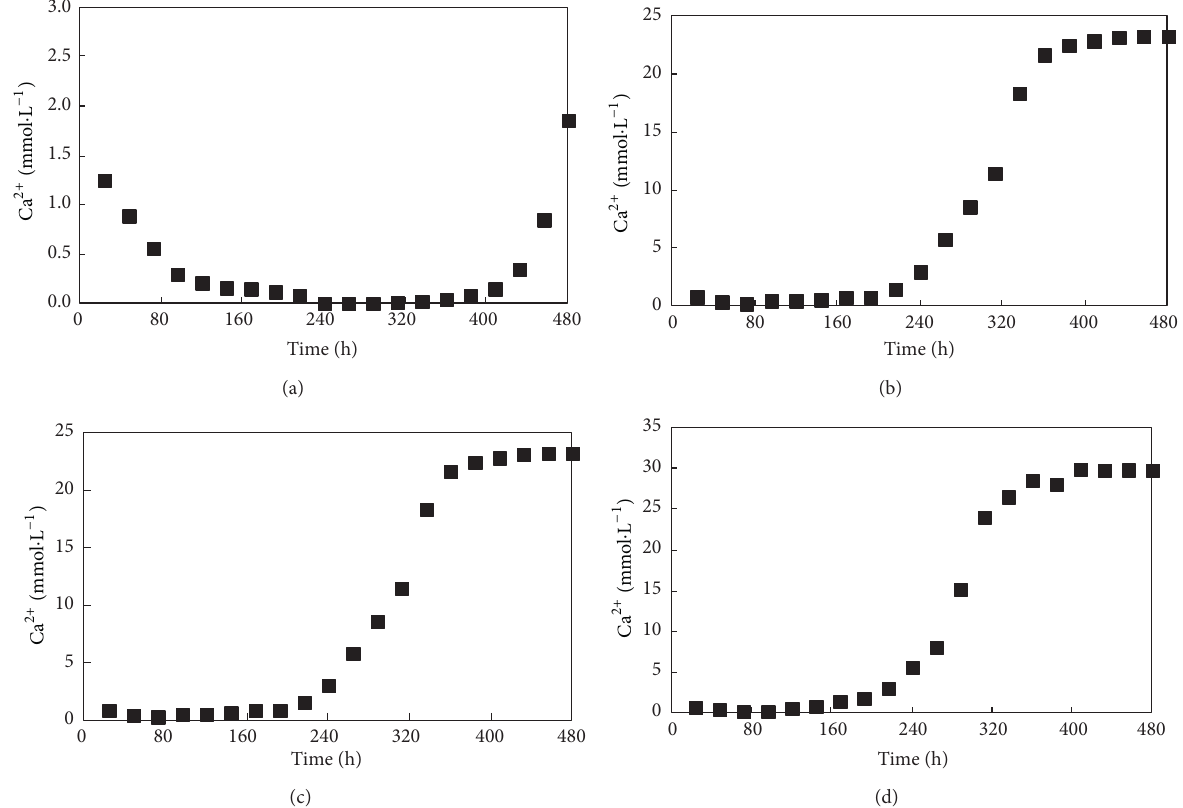
Figure 2: Changes in the measured values of Ca 2+ in the leachate with leaching times ((a) T 1; (b) T 2; (c) T 3; (d) T 4). The explanation of each condition ( T 1– T 4) is reported in Table